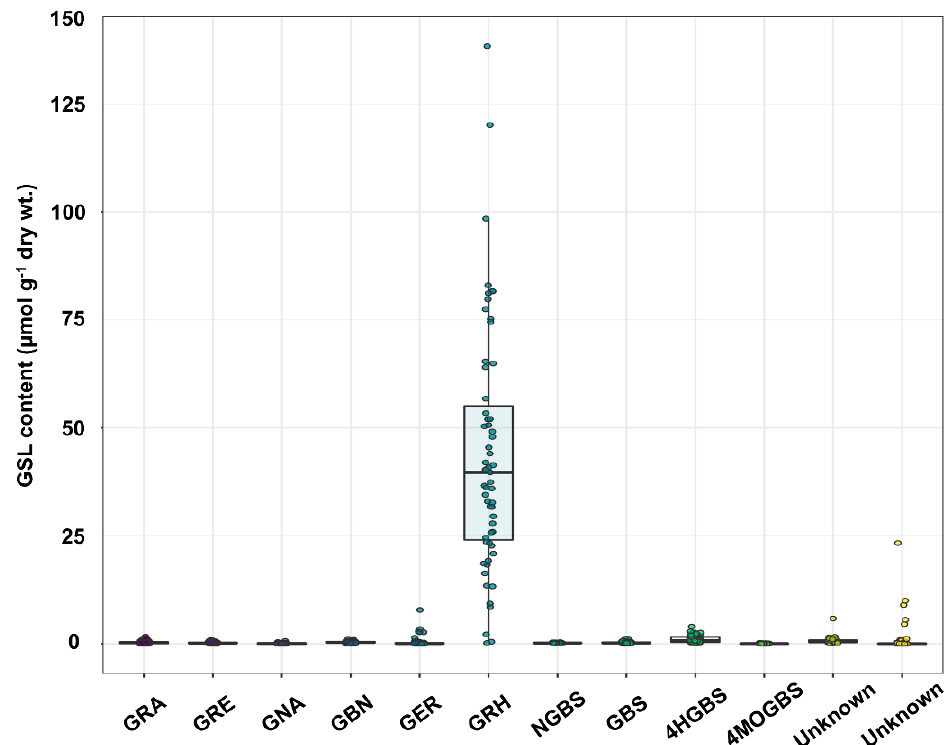
Figure 1. GSL profiling of a total of 59 radish accessions. Ten different GSLs, including glucoraphanin (GRA), glucoraphenin (GRE), gluconapin (GNA), glucobrassicanapin (GBN), glucoerucin (GER), glucoraphasatin (GRH), 4-hydroxyglucobrassicin (4HGBS), 4-methoxyglucobrassicin (4MOGBS), glucobrassicin (GBS) and neoglucobrassicin (NGBS) were identified in the radish roots.